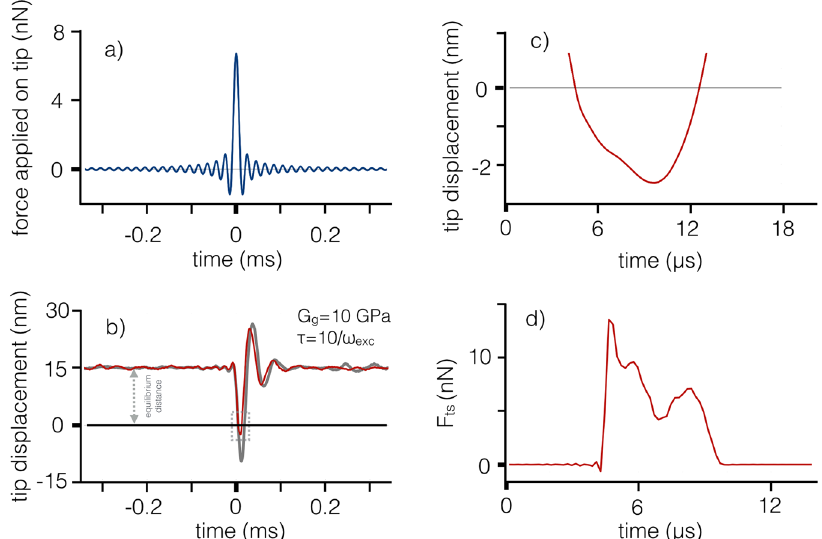
Figure 2. Impulsive excitation and calculated response for the tip interaction with a surface with material parameters G g = 10 GPa, τ = 10/ ω , where f res = ω exc /2 π = 20 kHz is the resonance frequency of the cantilever’s first flexural mode. ( a ) impulsive force applied to the tip in the form of a sinc function, with parameters reported in the text and the temporal zero set in coincidence with the sinc peak. Positive force applied on the tip points towards the surface. ( b ) the red trace is the calculated tip trajectory for a tip starting at an equilibrium distance of 15 nm, the surface being located at 0 nm. Note the indentation of the surface (negative displacements, dotted gray square) by the tip in the downward portion of the trajectory. The background gray trace is the free cantilever response to the same excitation, shown for comparison. ( c ) zoom of the previous graph around the indentation zone. ( d ) tip-sample force arising from the